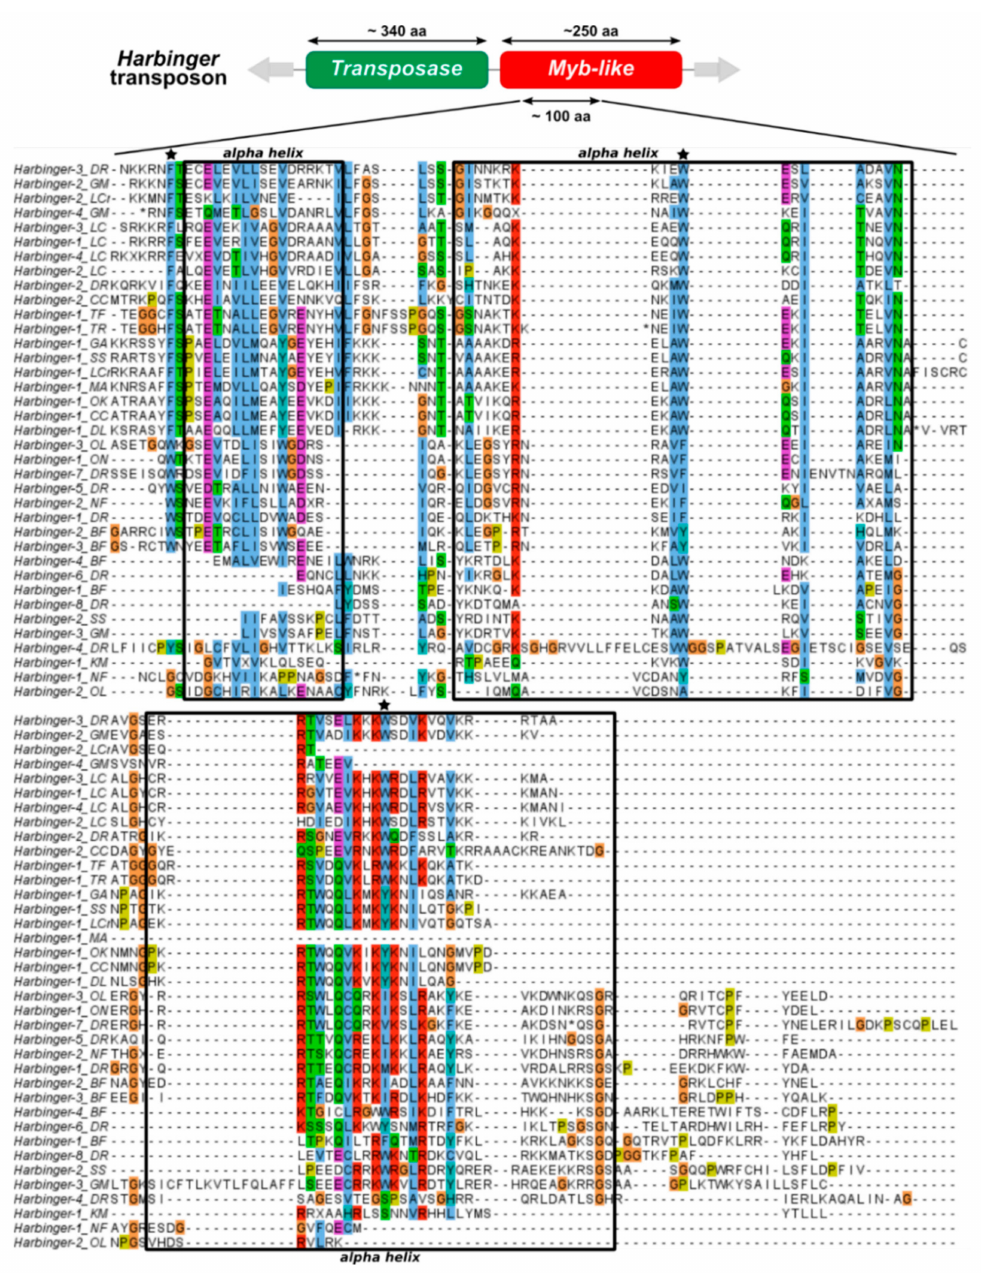
Figure 3. Multiple alignments of the Harbinger -like Myb -like proteins on the Myb -like domain. Predicted alpha-helix motifs are represented with black dashed squares; conserved similar amino- acid residues are shown by a same color; bulky aromatic residues, which are essential for alpha helix structure stabilization, are indicated by black pentagrams. BF: Branchiostoma floridae amphioxus, CC: Cyprinus carpio carp, DL: Dicentrarchus labrax bass, DR: Danio rerio zebrafish, GA: Gasterosteus aculeatus stickleback, GM: Gadus morhua cod, KM: Kryptolebias marmoratus killifish, LC: Latimeria chalumnae coelacanth, LCr: Larimichthys crocea croaker, MA: Monopterus albus eel, NF: Nothobranchius furzeri killifish, OK: Oncorhynchus kisutch silver salmon, OL: Oryzias latipes medaka, ON: Oreochromis niloticus tilapia, SS: Salmo salar salmon, TF: Takifugu flavidus fugu, TR: Takifugu rubripes fugu, XM: Xiphophorus maculatus